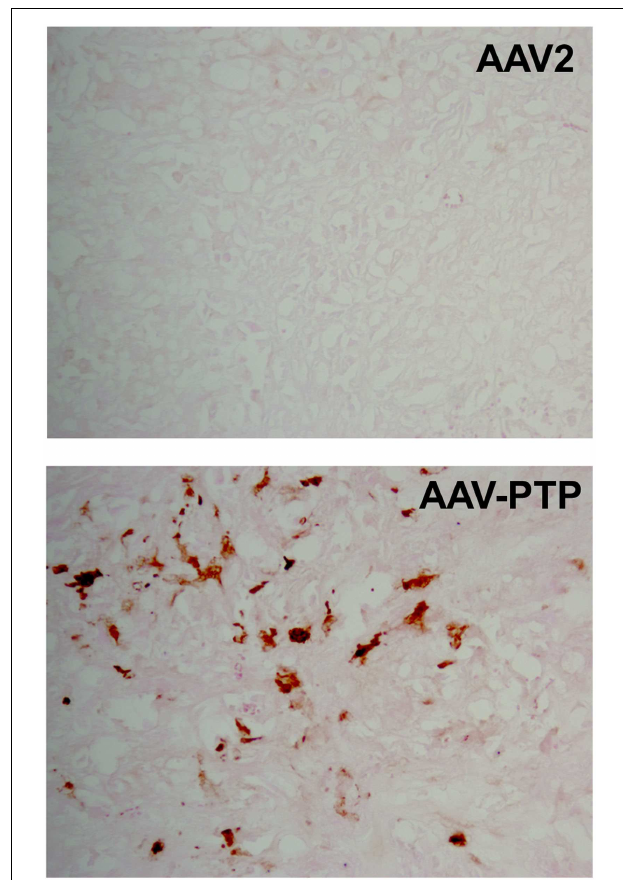
FIGURE 3 | Distribution ofAAV-PTP targeted PANC-1 cells in tumor xenografts. Immunohistochemistry for eGFP was performed on tumor sections to characterize the distribution of targeted gene delivery. Nude mice bearing PANC-1 tumor xenografts were injected intravenously with a single dose of AAV-PTP capsid carrying the sc-CBeGFP reporter vector genome (1 × 10 12 vg per mouse).Two weeks following vector administration, cryosections of tumors were prepared and processed for eGFP detection by immunohistochemistry. PANC-1 cells expressing eGFP were stained golden-brown in color by the chromogen substrate